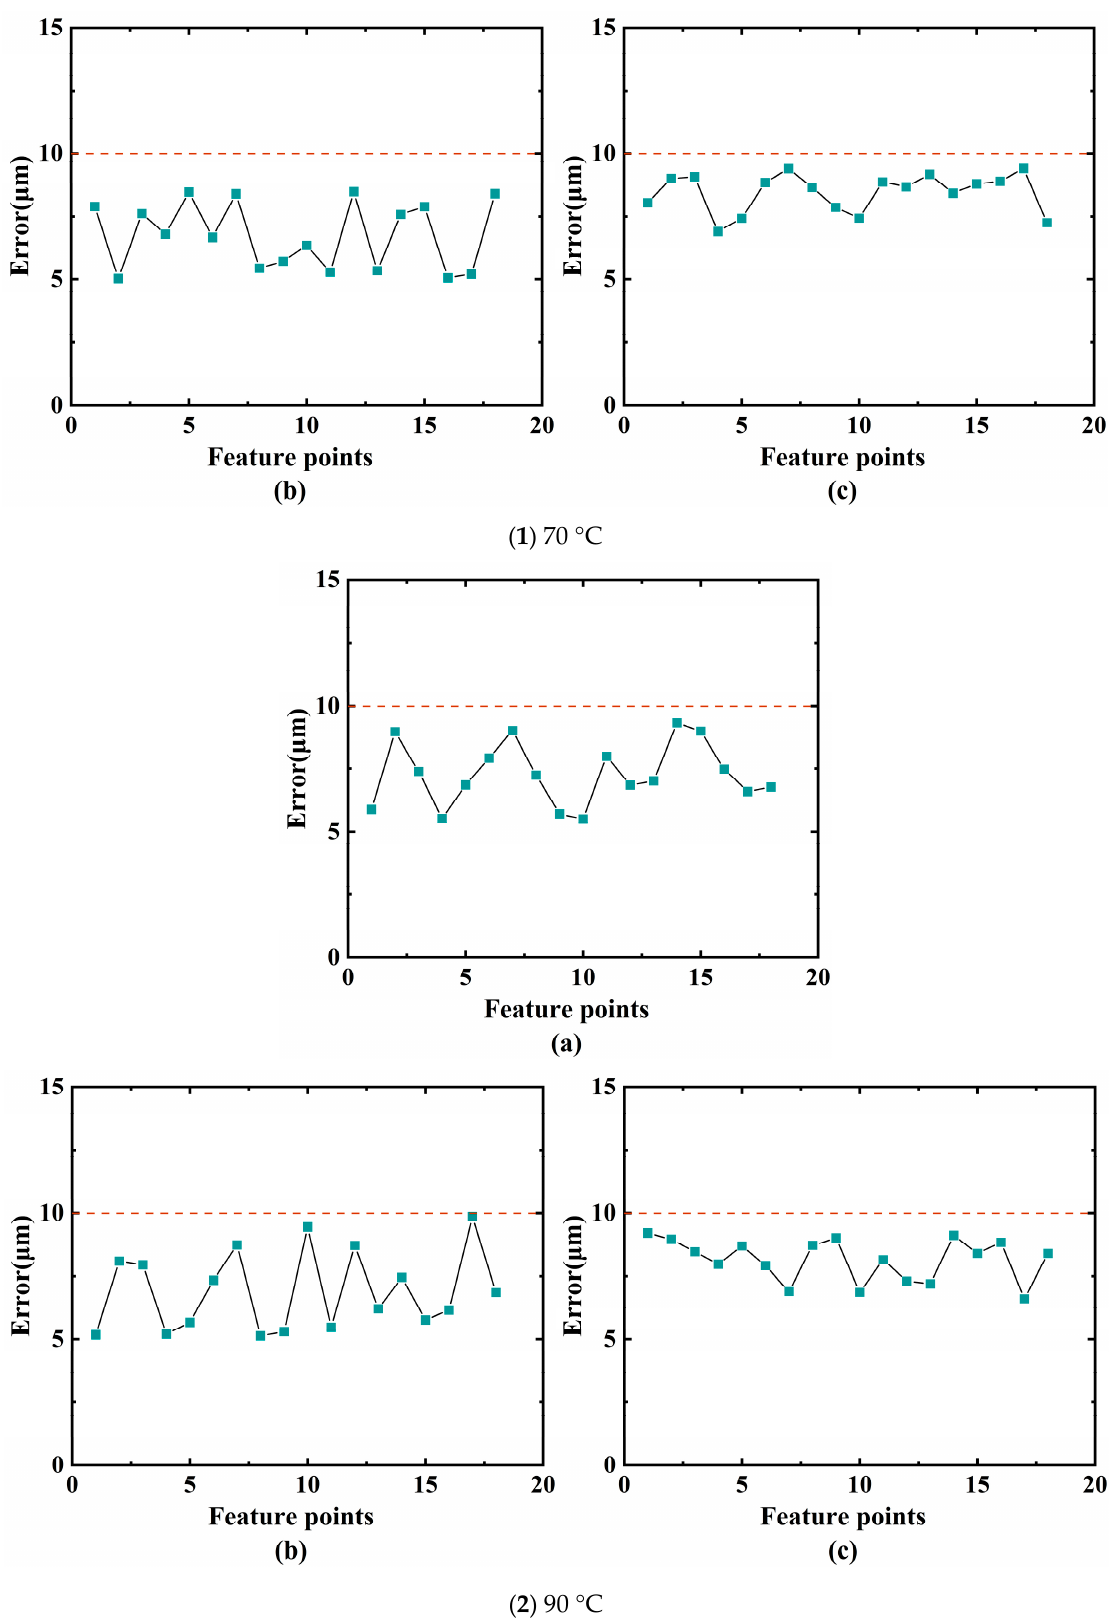
Figure 22. Deformation prediction accuracy of finite element model at feature points under ( 1 ) 70 °C and ( 2 ) 90 °C ( a ) X-direction ( b ) Y-direction ( c ) Z-direction. and ( 2 ) 90 ◦ C ( a ) X-direction ( b ) Y-direction ( c )